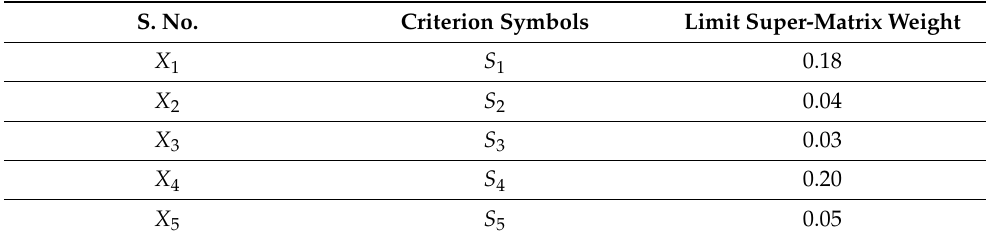
Table 4. Weights of the switches for the controller placement in cluster 1 (green). S. No.